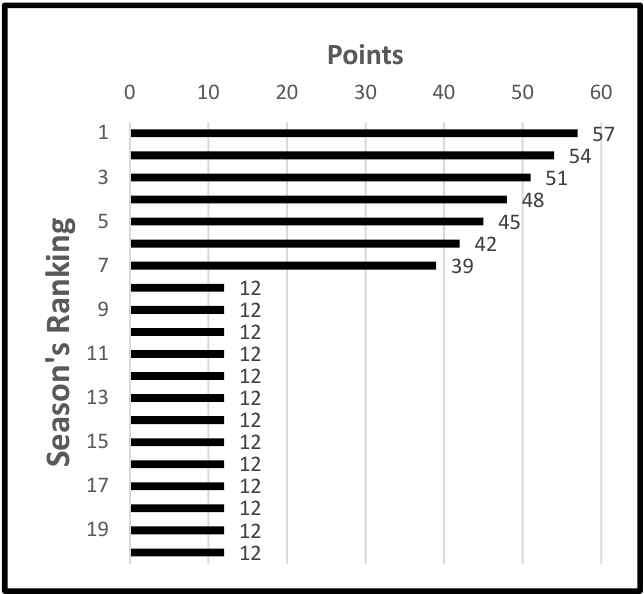
Figure 2. Truncated in q * = 7 cascade distribution ( N = 20). Scoring pattern {3, 1, 0}.